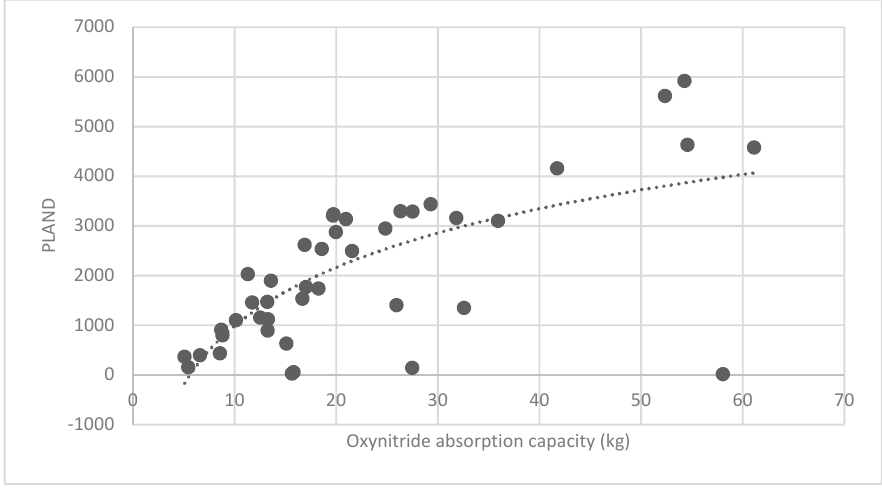
Figure 18. Association between forest land PLAND index and oxynitride absorption capacity.